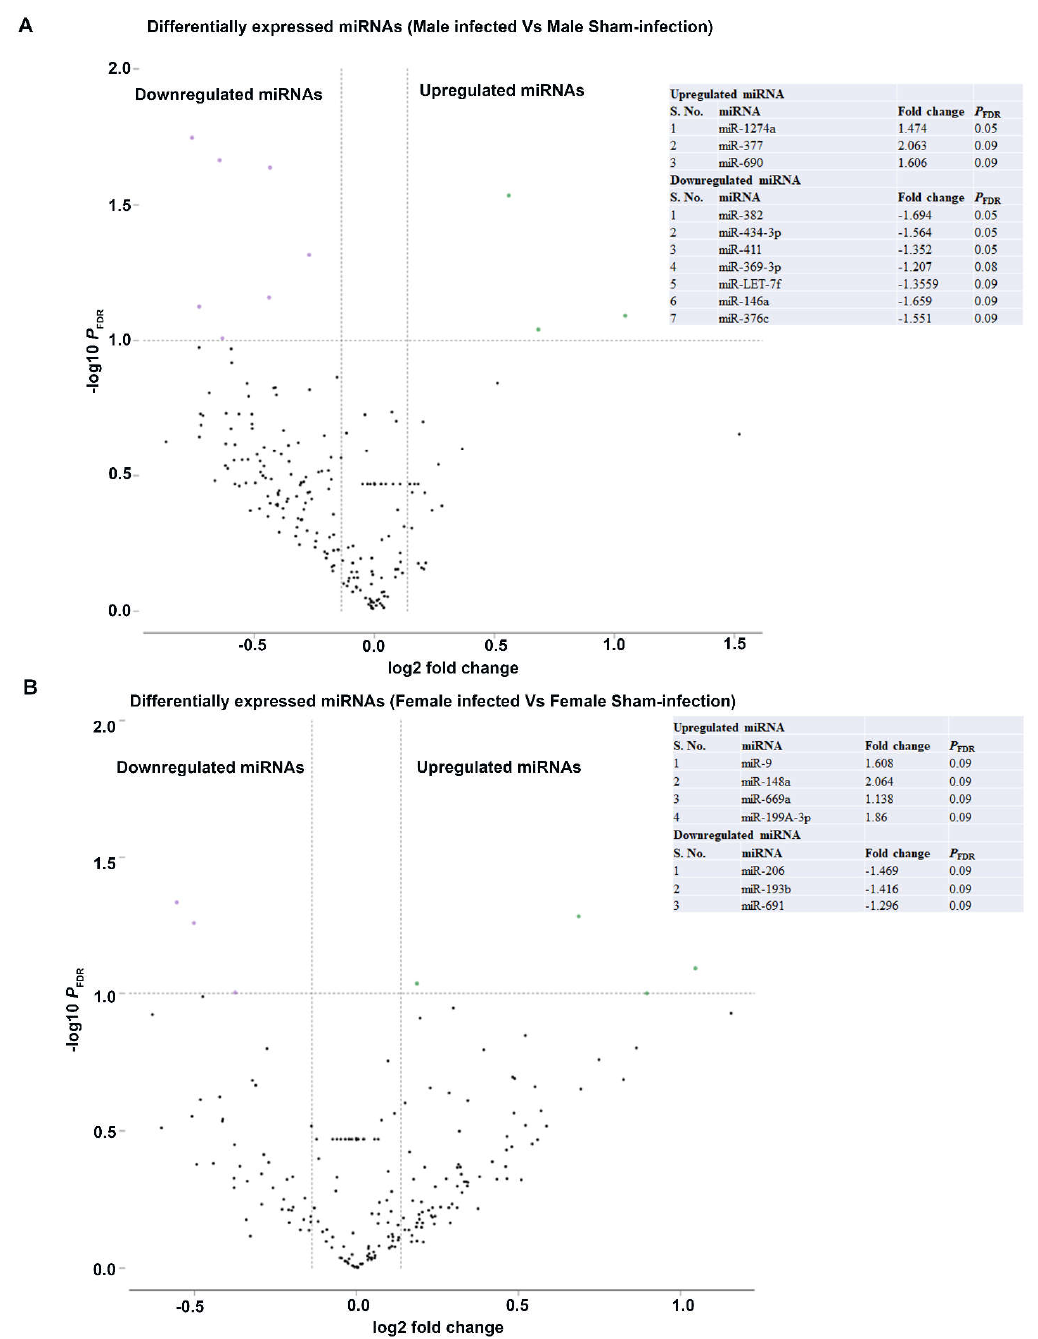
Figure 3. Differentially expressed miRNAs in male and female mice infected with partial human mouth microbes (PAHMM) compared to sham infection. ( A ) The volcano plot depicts the upregulated (green) and downregulated (purple) miRNAs that showed a fold difference of ± 1.1 with p FDR of < 0.1. The log ratio of the fold change is on the x -axis, and the negative log of the p -value is on the y -axis. The black dots represent the miRNAs that do not pass the filter parameters. Three significant upregulated miRNAs and seven significant downregulated miRNAs are shown in the table. ( B ) The volcano plot depicts the upregulated (green) and downregulated (purple) miRNAs that showed a fold difference of ± 1.1 with p FDR of < 0.1. The log ratio of the fold change is on the x -axis, and the negative log of the p FDR is on the y -axis. The black dots represent the miRNAs that do not pass the filter parameters. Four upregulated miRNAs and three downregulated miRNAs are shown in the